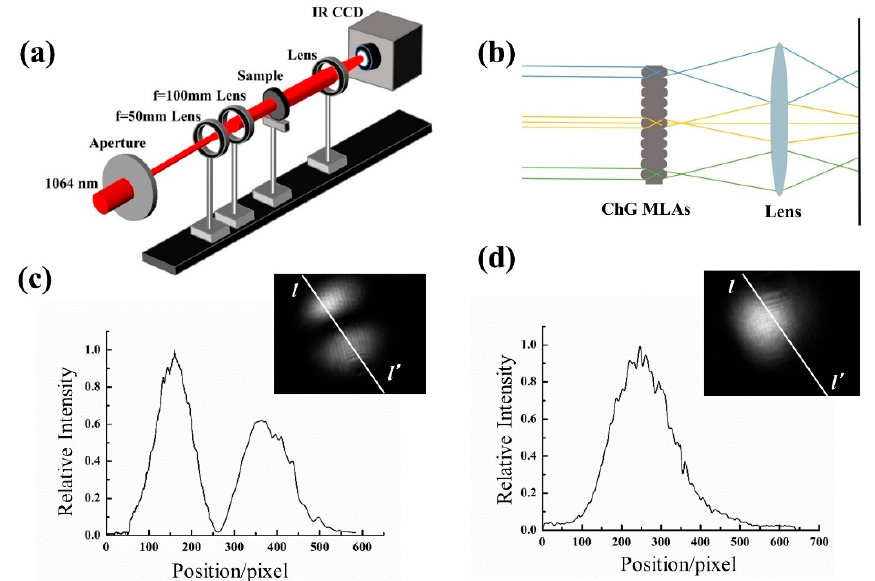
Figure 8. ( a ) Optical system used for measuring the illumination distribution; ( b ) a principle dia- gram of light beam homogenization by the microlens array; ( c , d ) cross-sections of light intensity before the homogenization of infrared light (multimode and Gaussian beam).